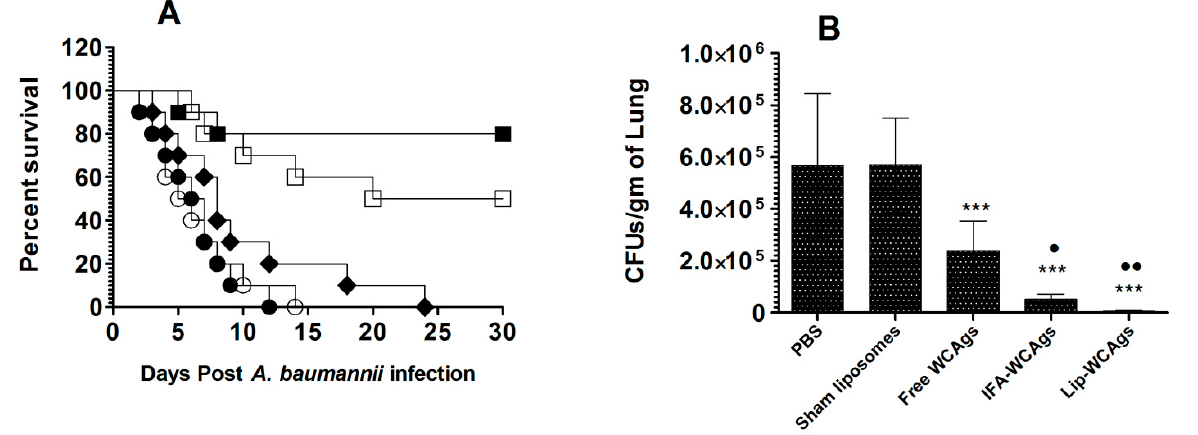
Figure 7. Mice immunized with Lip-WCAgs showed the highest resistance against the systemic infection of A. baumannii . ( A ) Each mouse from the immunized groups was intravenously infected with 5 × 10 6 cells with A. baumannii and was observed for 30 days. PBS ( ), Sham liposomes ( ), Free WCAgs ( ), IFA-WCAgs ( ), Lip-WCAgs ( ). ( B ) The bacterial burden was assessed as mentioned in the methods. *** p < 0.001, PBS vs. Free WCAgs, PBS vs. IFA-WCAgs, Sham liposomes vs. Lip-WCAgs; • p < 0.05, Free WCAgs vs. IFA-WCAgs, •• p < 0.01, Free WCAgs vs. Lip-WCAgs. The values are shown as the means ± SD.